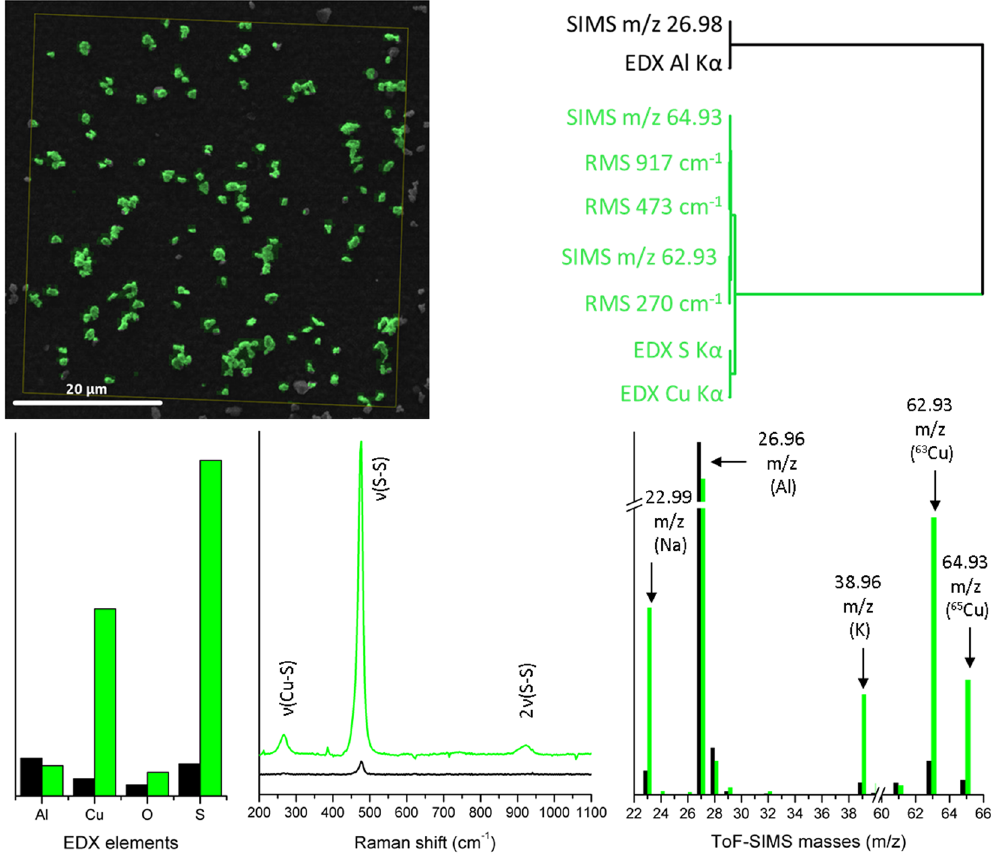
Figure 2. Superposition of the high-resolution SEM image with the CuS particle cluster of the HCA of the loadings of the PCA, dendrogram of the PCA-HCA indicating the background (black) and CuS particle cluster (green), and the extracted cluster spectra from the k-means